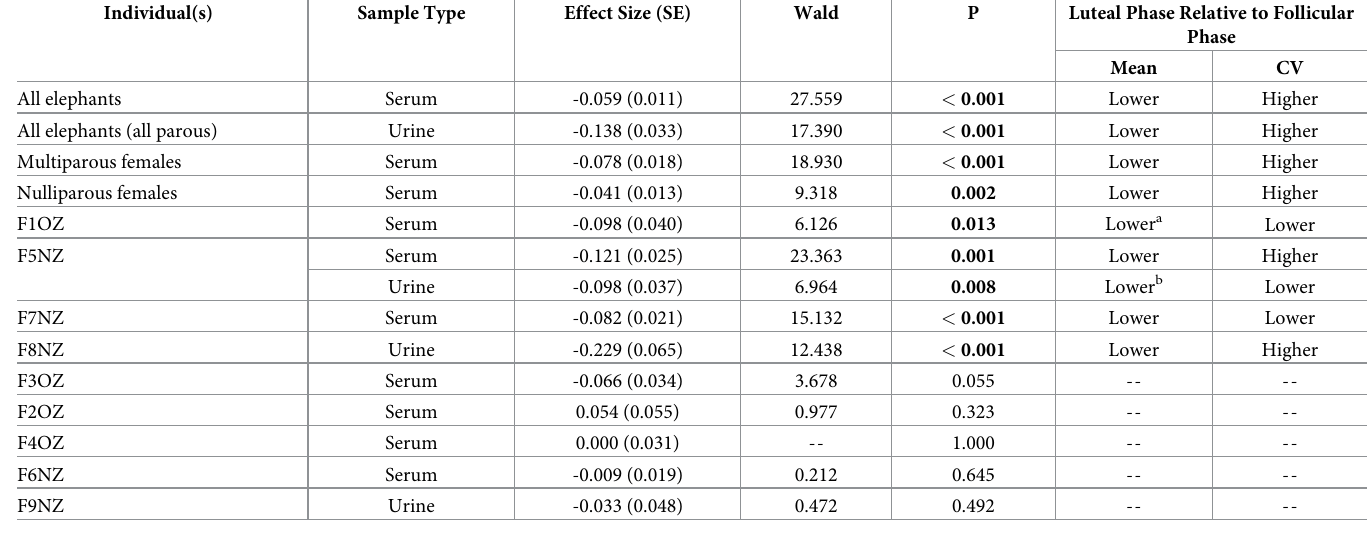
Table 2. Ovarian cycle phase as a predictor of adrenal GC activity. Individual, sample type, effect size with standard error (SE), Wald statistic, and p-value from GLMMs, and whether the mean and coefficient of variation (CV) in cortisol in the luteal phase was higher or lower than in the follicular phase. Degrees of freedom (df) was 1 in all pair-wise